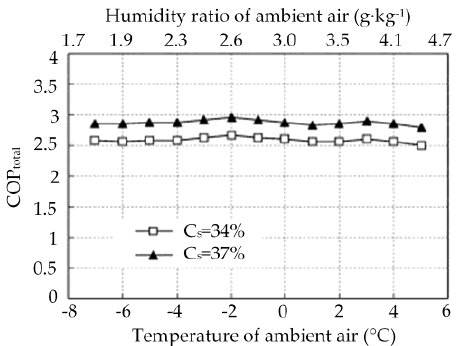
Figure 20. Effect of lithium chloride solution concentration on COP total [84].